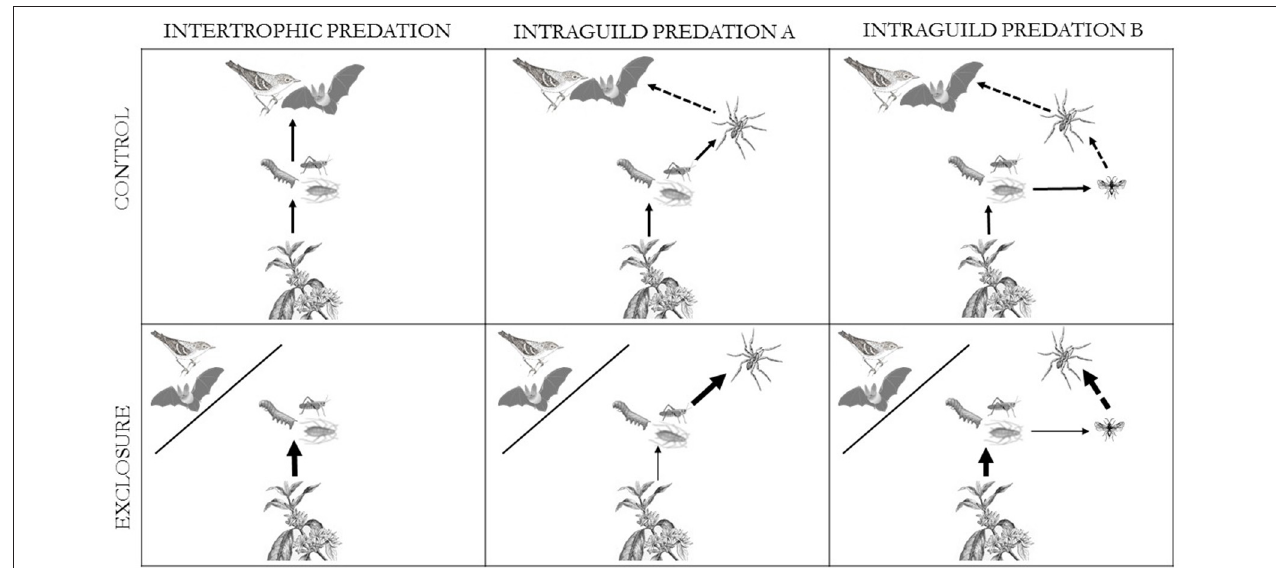
FIGURE 1 | Conceptual figure illustrating potential trophic dynamics with (1) only direct inter-trophic consumption, (2) intraguild predation between VVIs and arthropod predators, and (3) intraguild predation between both VVIs and arthropod predators and among arthropod predators. Intraguild predation is indicated by a dashed arrows and inter-trophic interactions are denoted with solid arrows. Modified from Perfecto and Vandermeer (2015) with additional vector elements from Tracey Saxby (Integration and Application Network,